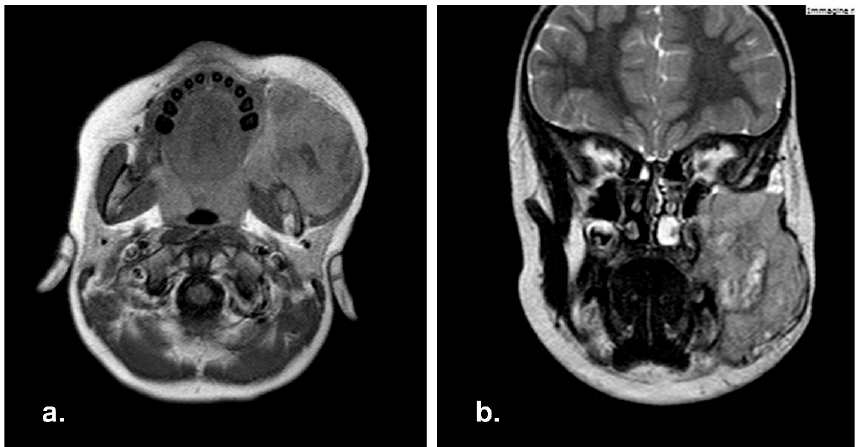
Figure 6. Pre-operative Magnetic Resonance Imaging (MRI) in axial ( a ) and coronal ( b ) view with showing a massive neoplasia in the right masticatory